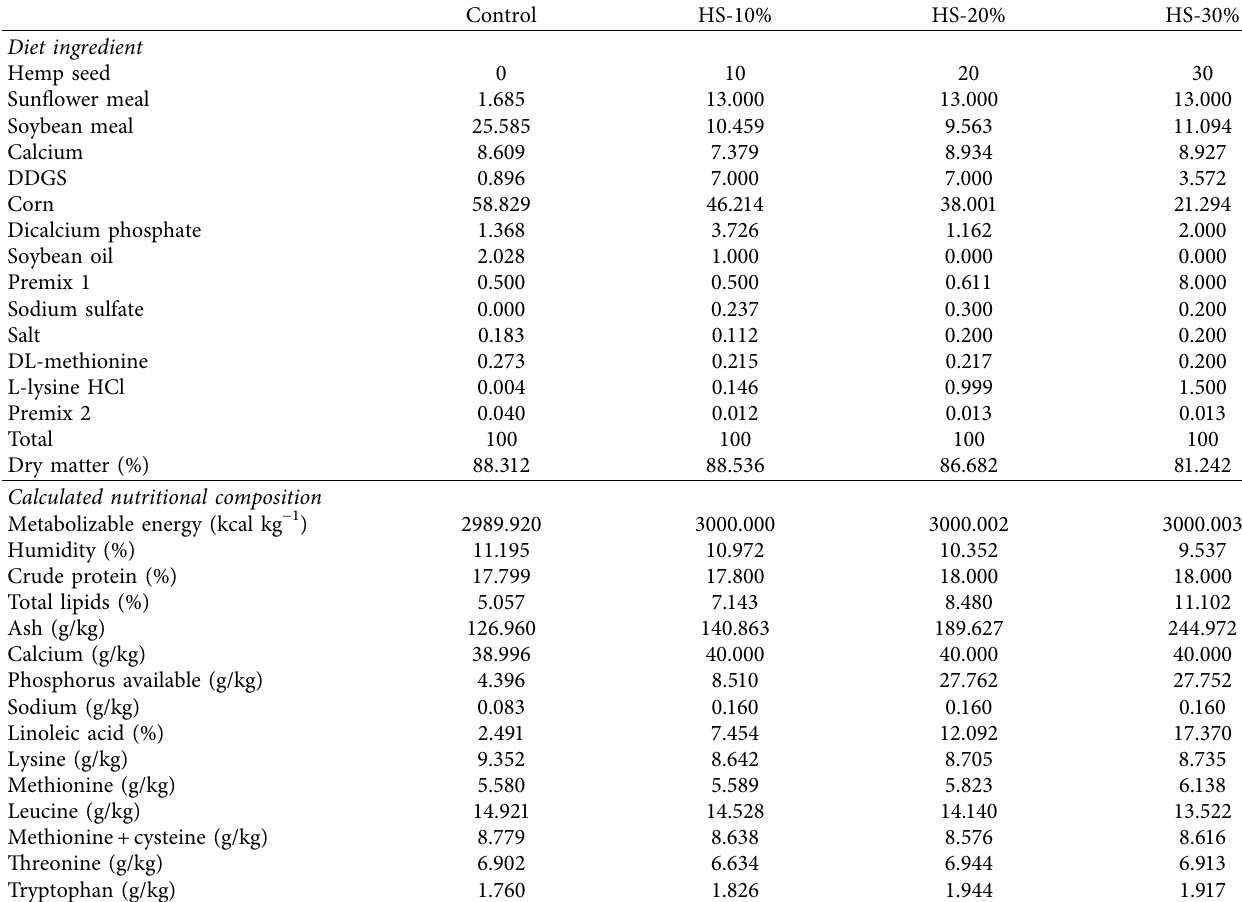
Table 2: Diet composition and its calculated nutritional